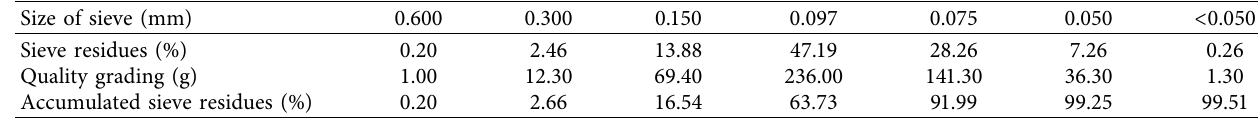
Table 2: Sieve analysis of Mu Us desert sand.